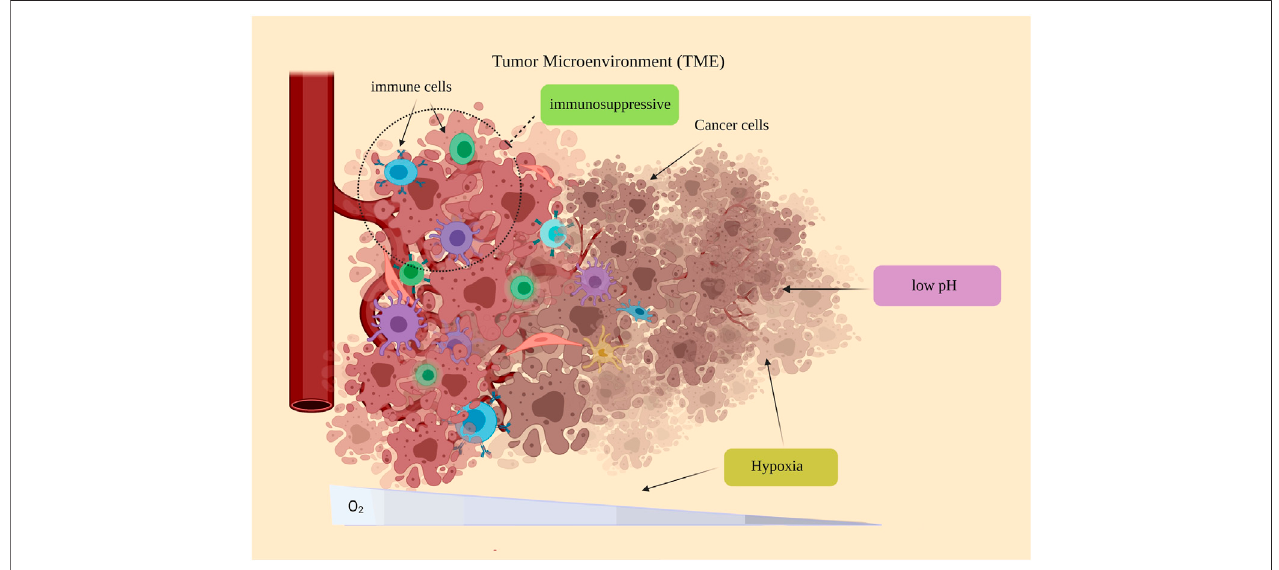
FIGURE 2 | Some special features of the TME: hypoxia, low pH, and immunosuppressive environment. The immunosuppressive environment of TME has been observed in many cancers. Because of rapid proliferation and the imbalance between oxygen supply and consumption, the TME oxygen level tends to be reduced, which is ascribed as hypoxic regions observed in most tumors. PH reduction is another feature of